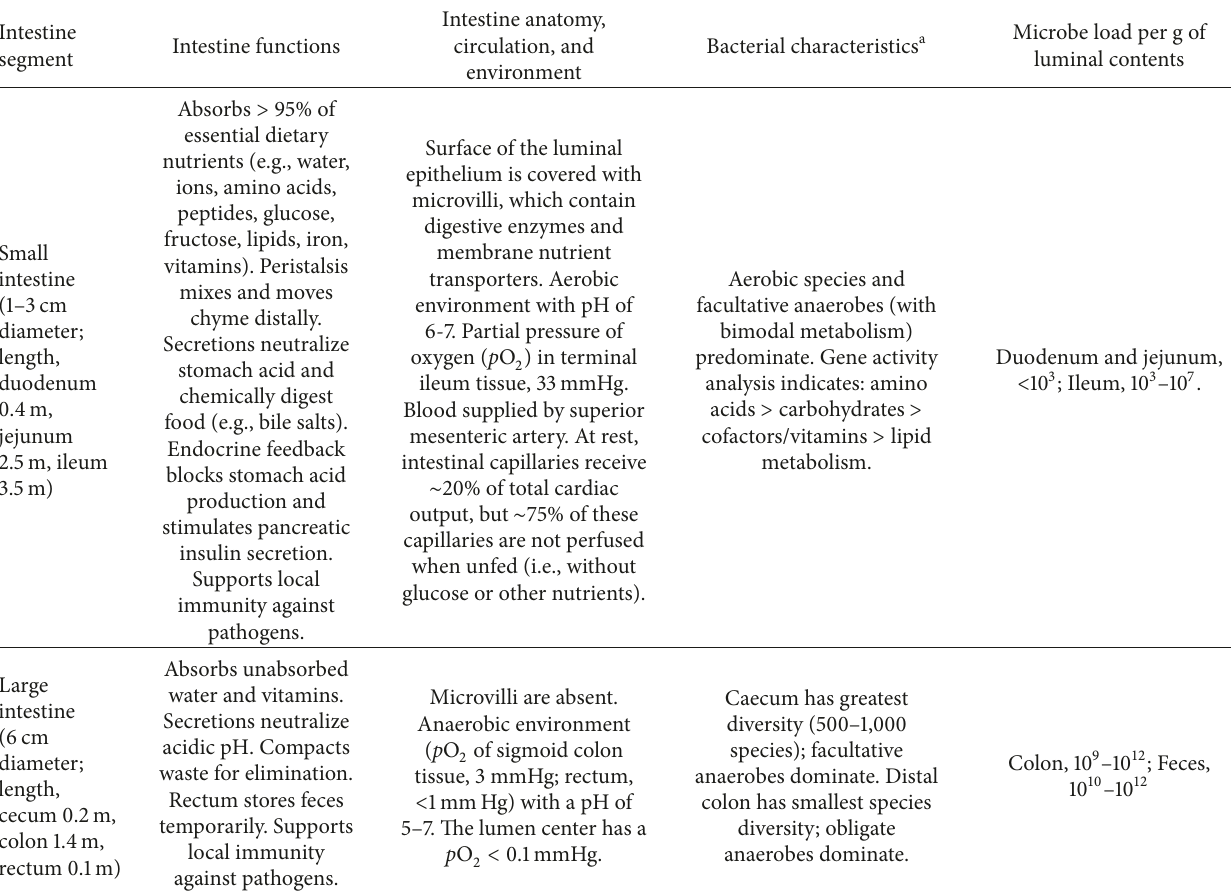
Table 3: Characteristics of the human intestine and resident